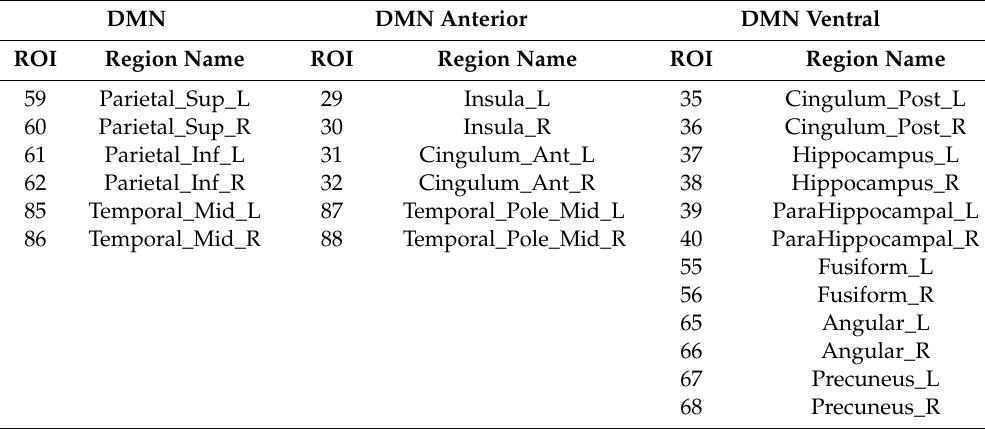
Table 1. Relationship of regions of interest (ROIs) for the construction of the Default Mode Network (DMN) and subnetworks considered according to the AAL90 atlas.